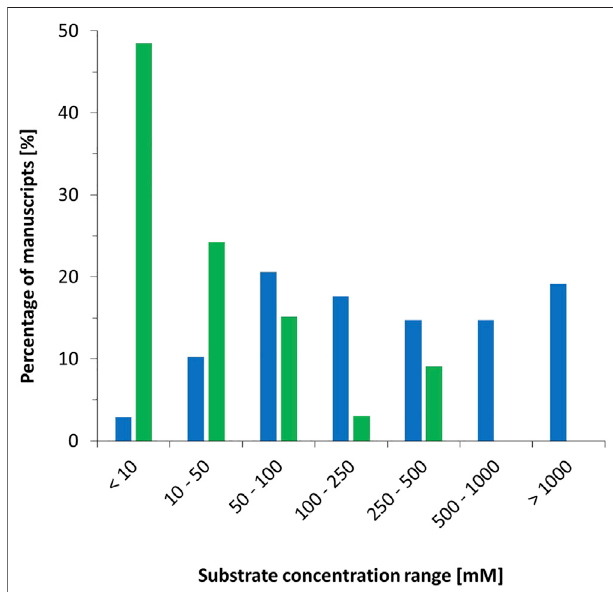
FIGURE 4 | Substrate concentrations reported in publications in ChemCatChem [vol. 12 (2020), issues 1 – 12]. Green: for biocatalytic contributions(33intotal),blue:forchemocatalyticcontributionsinliquidphase (68: in total).